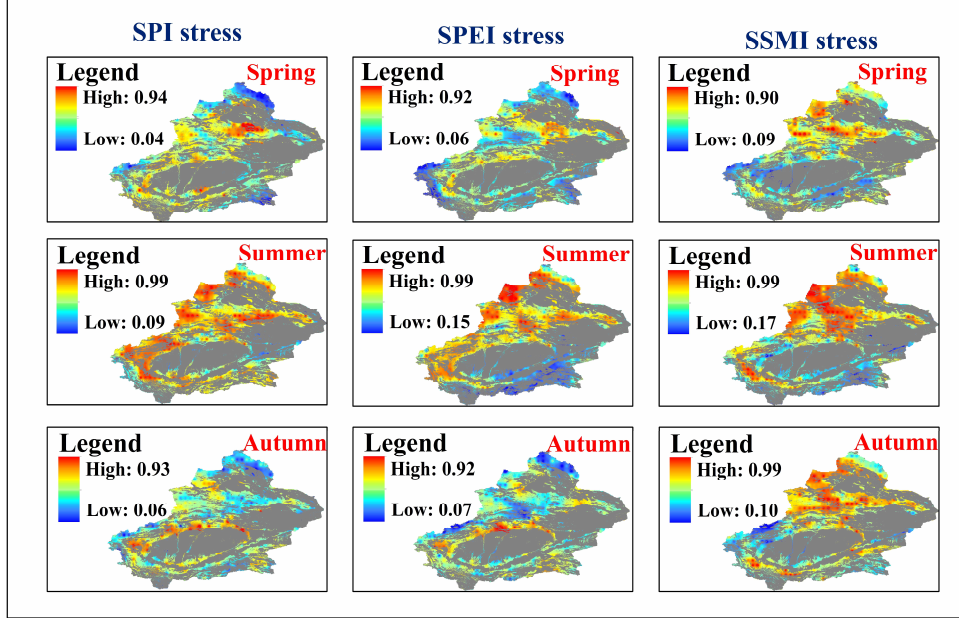
Figure 5. The spatial distribution of the conditional probability of NDVI vulnerability under extreme drought.